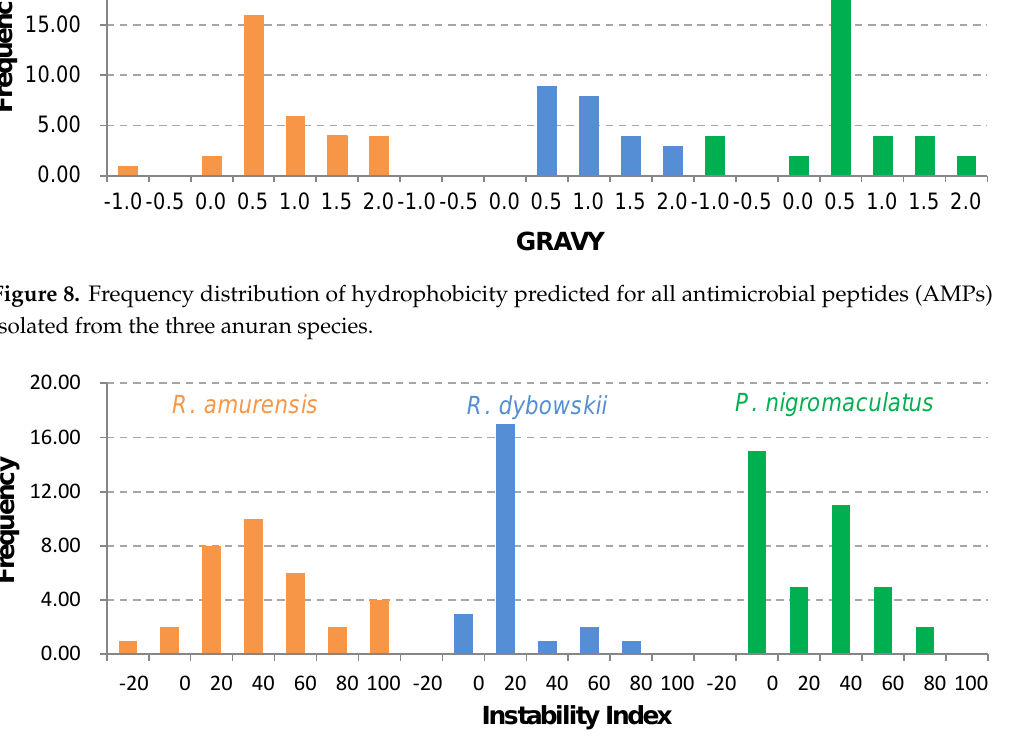
Figure 9. Frequency distribution of Instability index (II) values of all antimicrobial peptides (AMPs) isolated from the three anuran species.